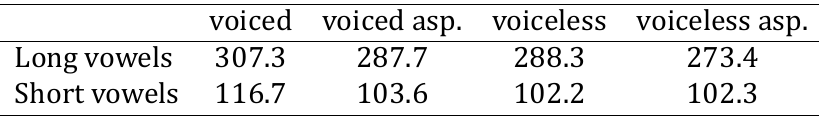
Table 3: Telugu vowel durations (ms), by following consonant